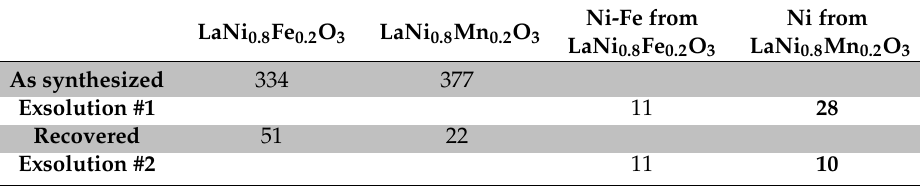
Table 1. XRD Domain Size from Reitveld Analysis